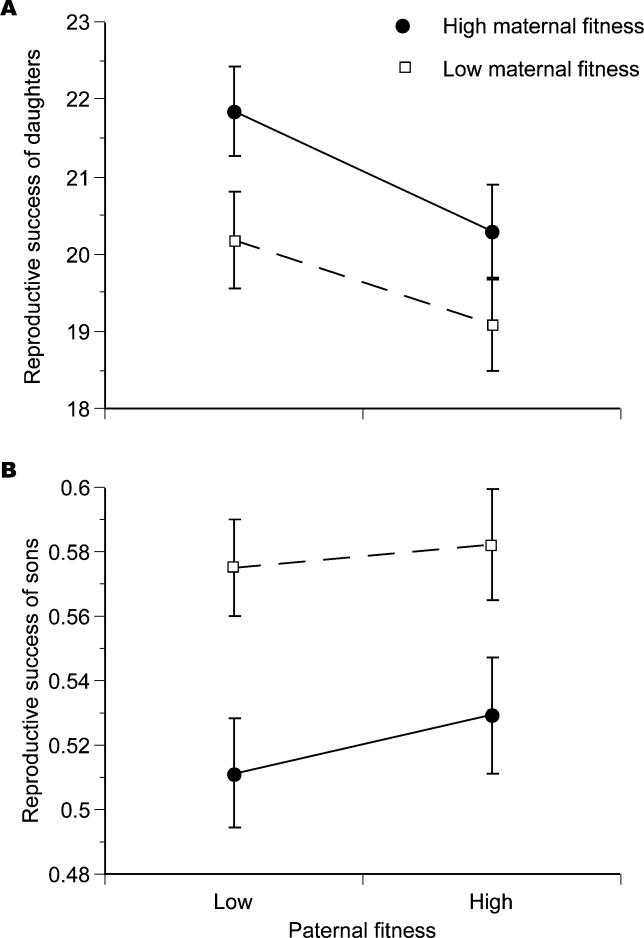
X-Linked SA Variation Results in an Inverted Pattern of Fitness Inheritance from Fathers to Daughters and Mothers to Sons(A) Daughter reproductive success, measured as egg production in an 18-h period, was positively related to maternal fitness and negatively related to paternal fitness.(B) In contrast, son reproductive success, measured as the proportion of offspring fathered, was negatively related to maternal fitness and unaffected by paternal fitness.Error bars indicate standard errors.